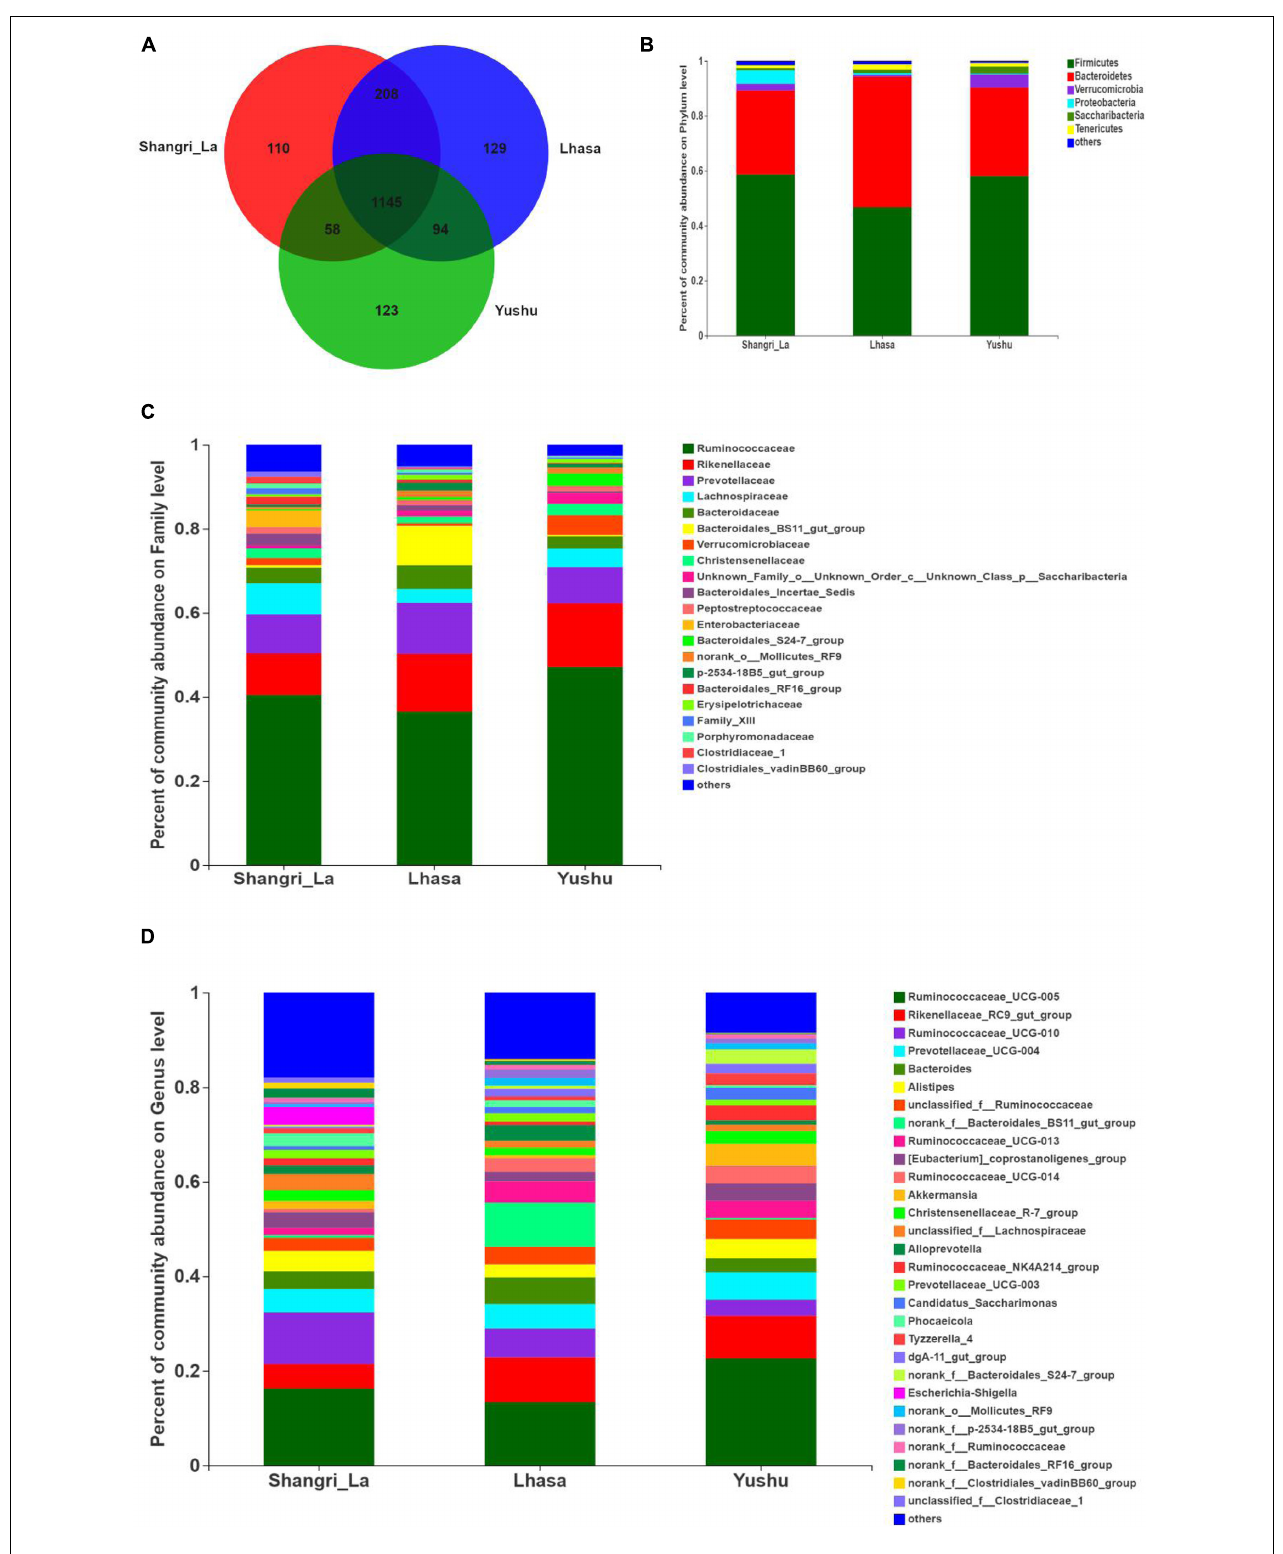
FIGURE 4 | Composition of gut microbiota of yaks from different regions. (A) Venn analysis. (B) Relative abundance of community at the phylum level. (C) Relative abundance of community at the family level. (D) Relative abundance of community at the genus level.